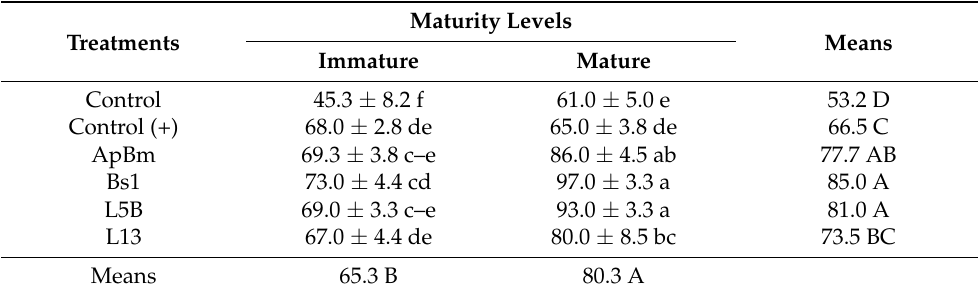
Table 4. Effect of endophytic bacteria inoculation on mean emergence percentages of immature and mature pepper seeds.